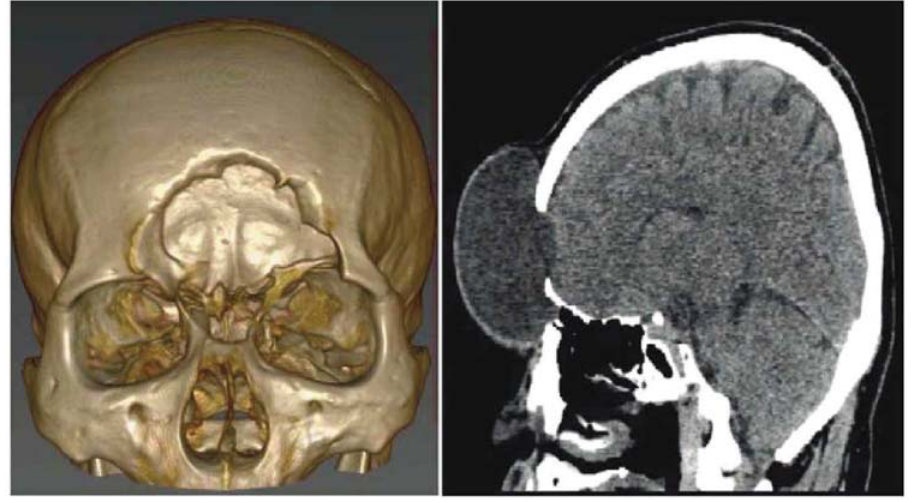
Fig 2. 3D slicer image of a patient with head